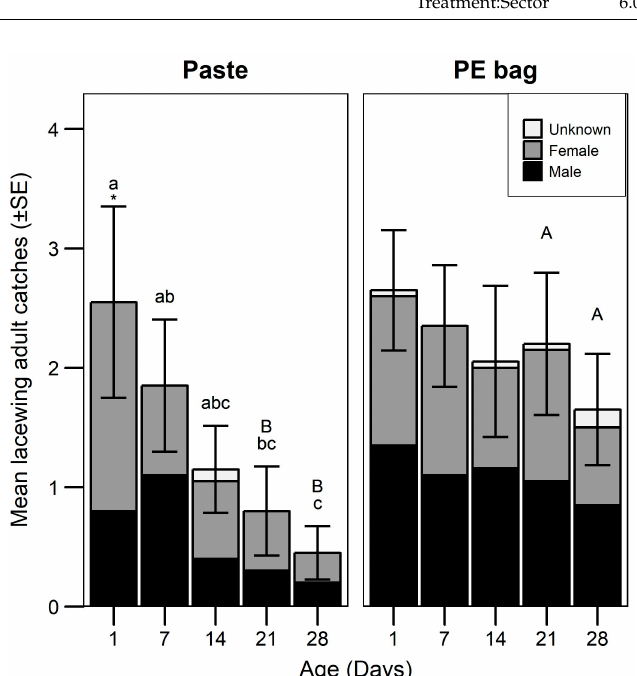
Figure 2. Mean catches (±SE) of lacewing adults in apple orchards by two different emitting devices at 1, 7, 14, 21, and 28 day of field exposure (N = 5). The lower part of the bar indicates the proportion of males, middle the proportion of females, and top the proportion of individuals that could not be sexed. Different uppercase letters above the bar indicates a significant difference of catches between the two formulations at a given age (GLMM, Tukey’s test, p < 0.05). Different lowercase letters indicate significant differences between ages within the same formulation (GLMM, Tukey’s test, p < 0.05). An * above bars indicate significant higher ratio of females at the corresponding age (GLM, Tukey’s test, p < 0.05).